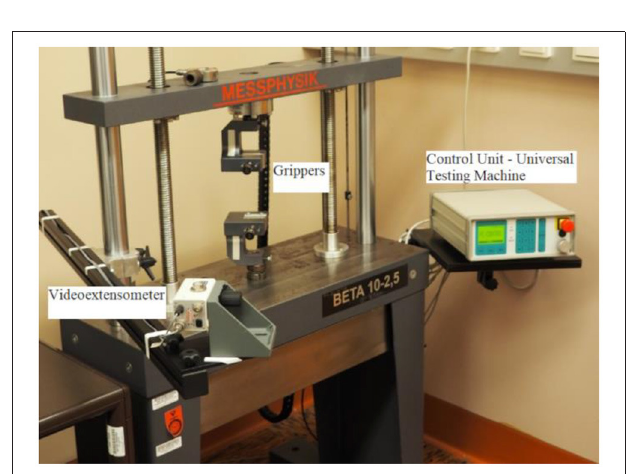
FIGURE 3 | Tensile test machine including a video extensometer